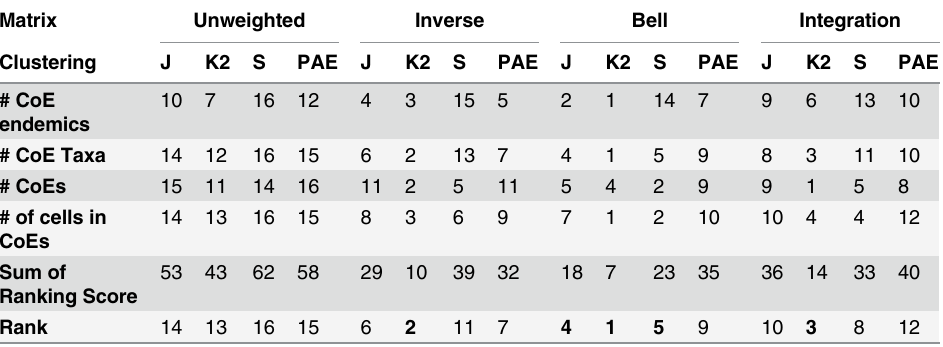
Rankings were based on the optimality values in Table 2. The Consensus CoEs / Sub-CoEs were excluded from the ranking assessment. J = Jaccard, K2 = Kulczinsky2, S = Simpson.